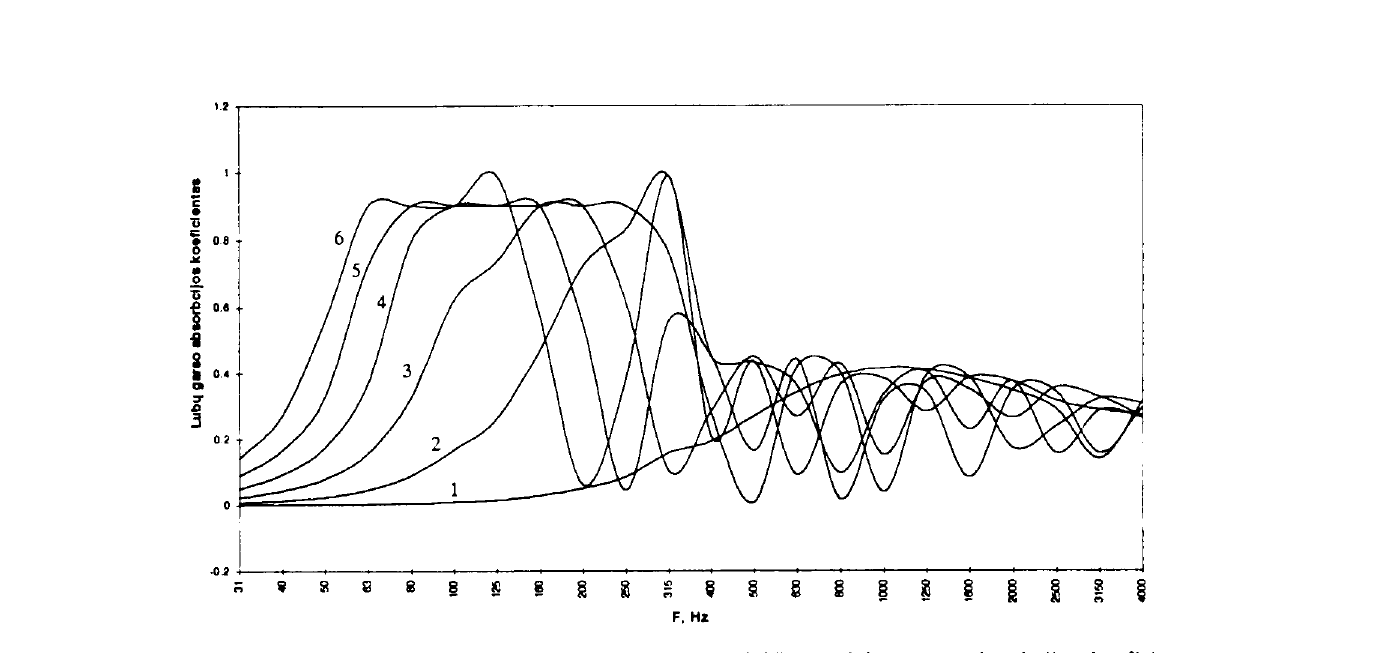
6 pav. Kabamll,jq lubq su kryziaus fonnos plysiais tarp plok.Stumq lubq garso absorbcijos koeficientq priklausomybe Duo atstumo tarp plokStumos ir staDdaus lubq paviriiaus. Plysio plotis - 100 em. 1, 2, 3, 4, 5 ir 6 atstumas iki staDdaus paviriiaus atitinkamai 5, 20, 35, 50, 65 ir 80 em